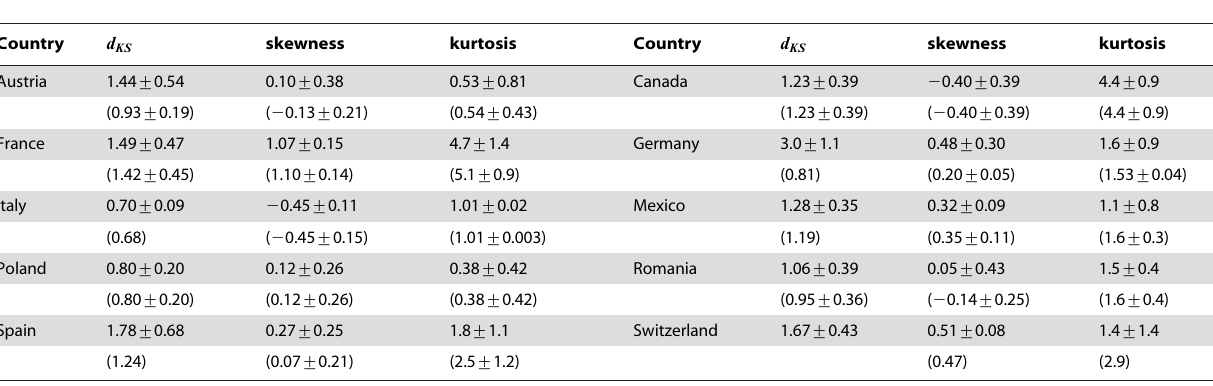
Table 1. Mean and standard-deviation of KS distances ( d KS ) between all pairs of elections within each country.